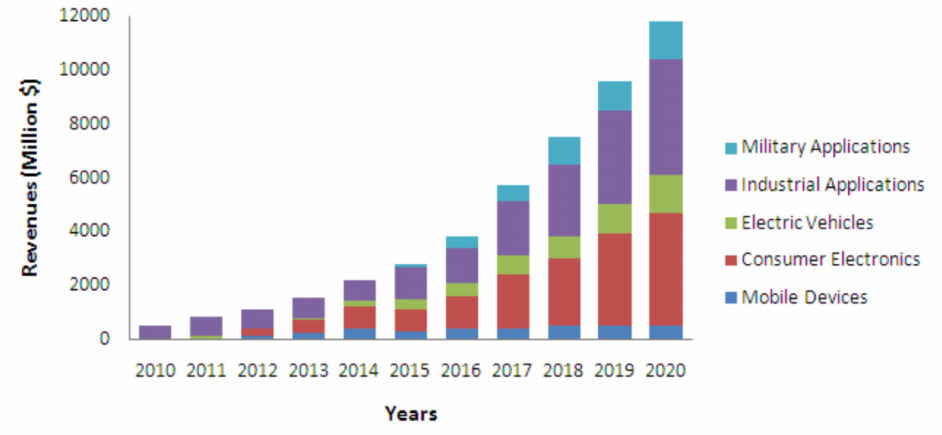
Figure 3. Predicted values of WPT technology in 2020